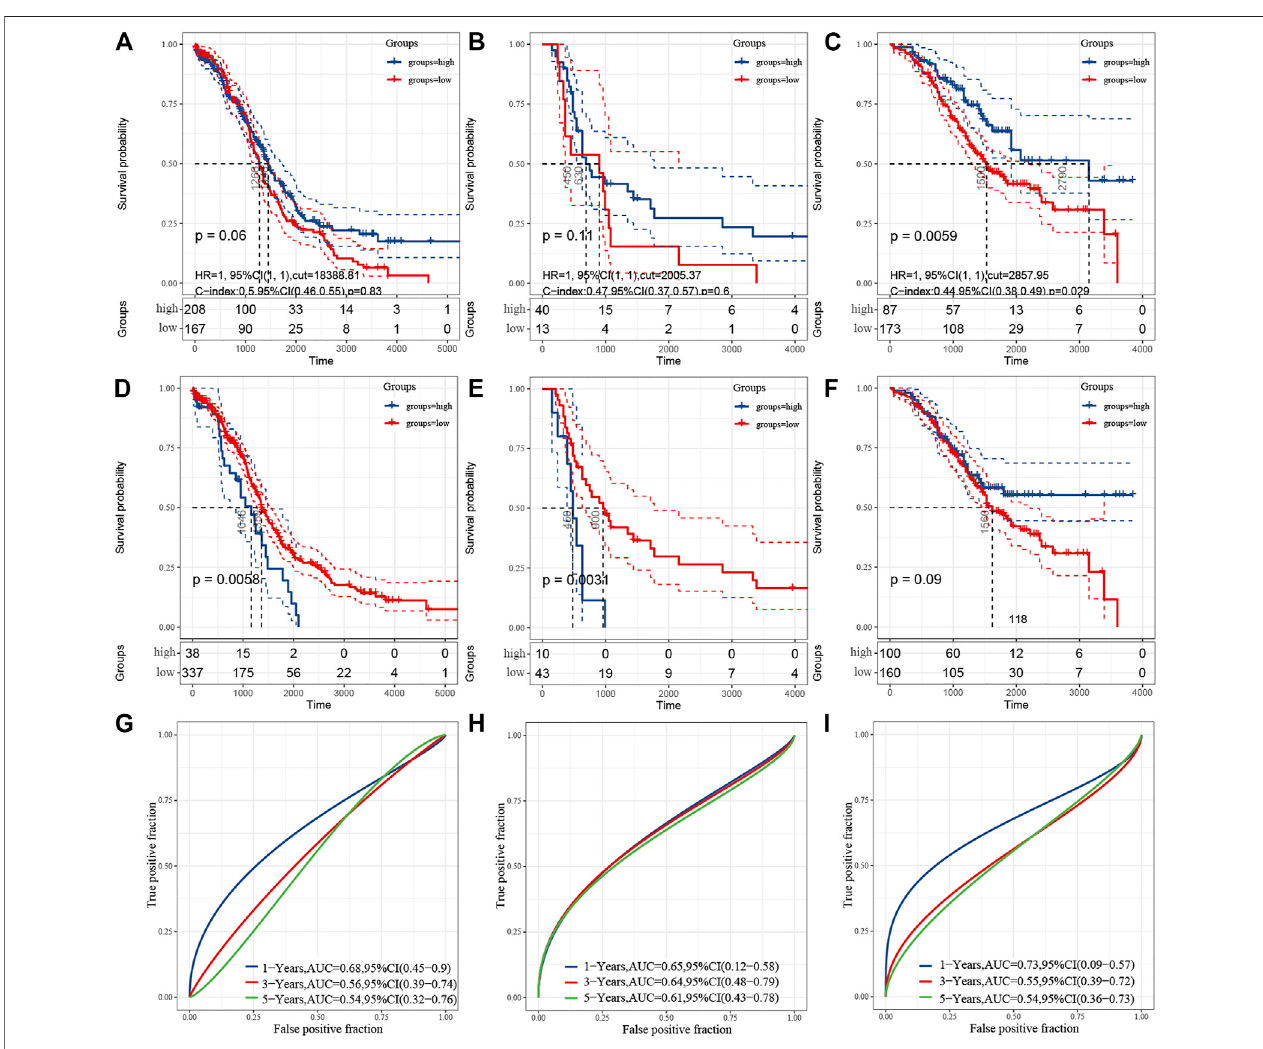
FIGURE 3 | Correlation with the estimation of tumor-in fi ltrating cells and prognosis. (A – C) Kaplan – Meier survival analysis showing association between immune score and OS. (D – F) Kaplan – Meier survival analysis showing association between stromal score and OS. A and D represent TCGA, B and E represent GSE18520, C andFrepresentGSE32062.G – I,ROCcurveformeasuringthepredictivevalueofimmunescoreorstromalscoreforOSinGSE18520. (G) representstheimmunescore. (H) represents the stromal score. (I) represents the ESTIMATEscore.